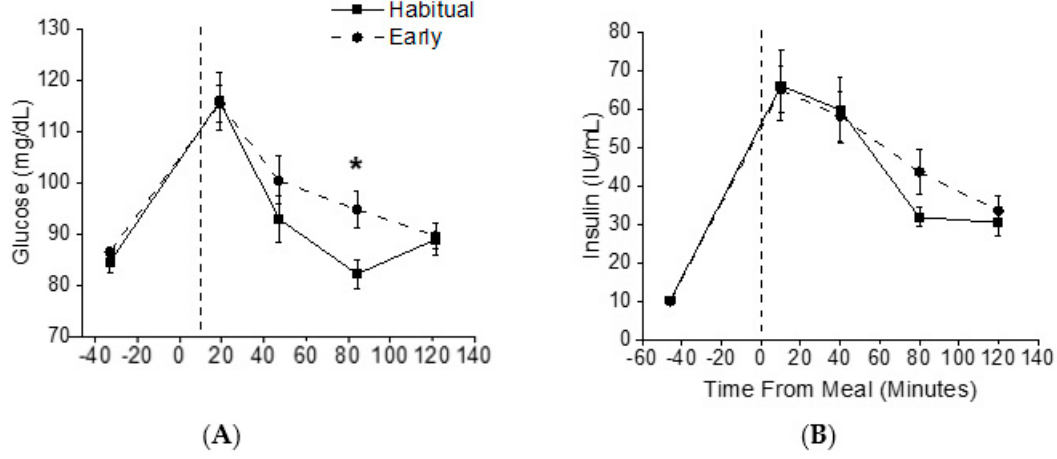
Figure 3. Glucose and Insulin Concentrations. Plasma glucose ( A ) and insulin ( B ) levels during habitual sleep (squares) and simulated early morning shift work (circles) conditions. The vertical dashed line represents the start of the scheduled meal. * Denotes p < 0.05 between time points.